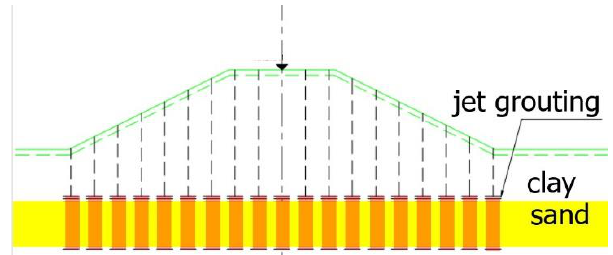
Figure 13. The solution for cracks under the embankment: at the locations of cracks, it is necessary to remove the soil to a depth of at least 1.5 m, and to a width of 1 m, and to compact the clay material in layers.